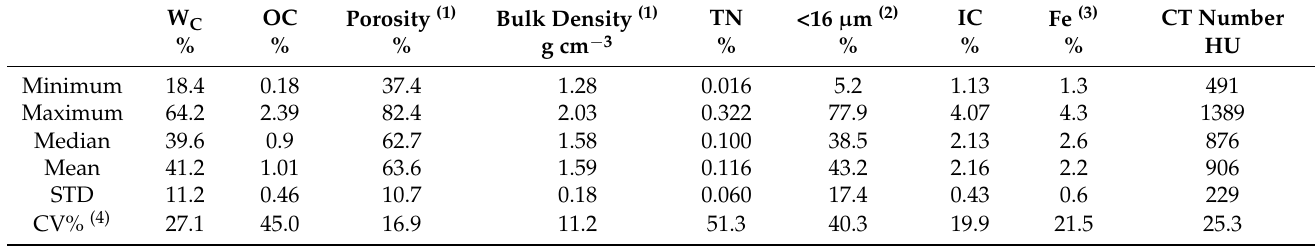
Table 1. Statistical description of the relevant variables measured in the 252 sediment samples collected from the 24 cores. (1) calculated from water content (W C ) using Equations (3) and (4); (2) percentage of particles with diameter <16 μ m; (3) Fe concentration extractable with 8N HNO 3 ; (4) coefficient of variation.